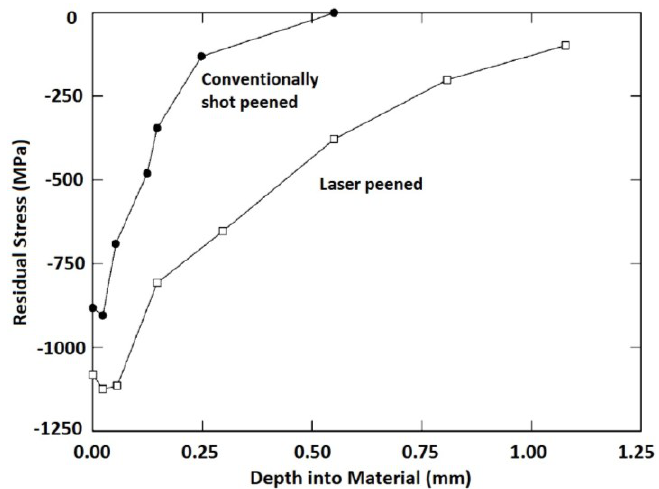
Figure 2. Residual stress profile in Inconel 718 induced by LSP and SP